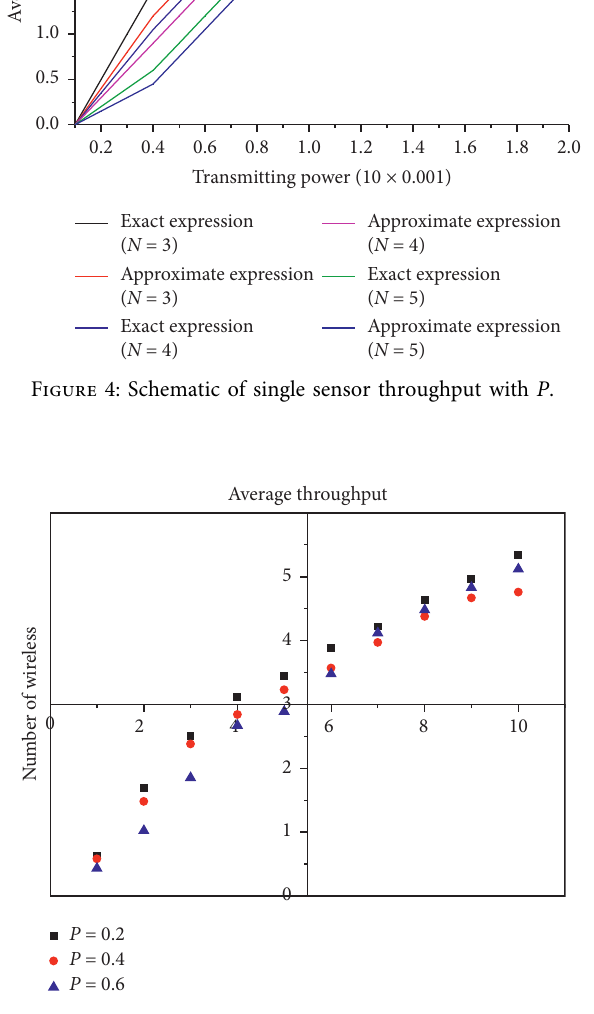
Figure 5: Schematic of the average throughput of a single sensor with N .